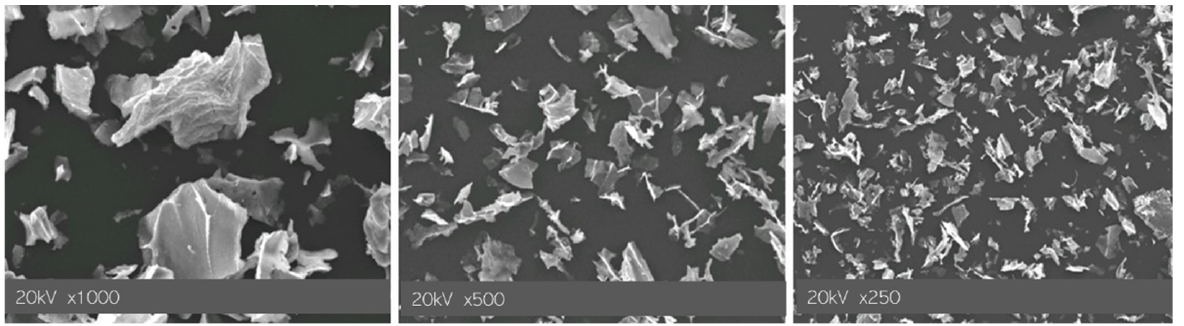
Figure 3. SEM images of Fe 3 O 4 nanoparticles.